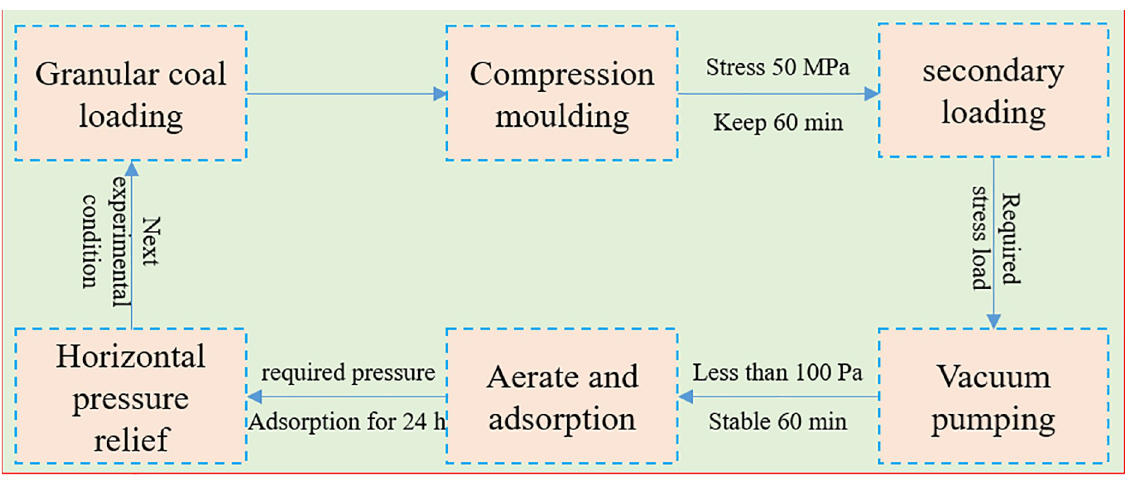
Fig 3. Experimental flow chart.